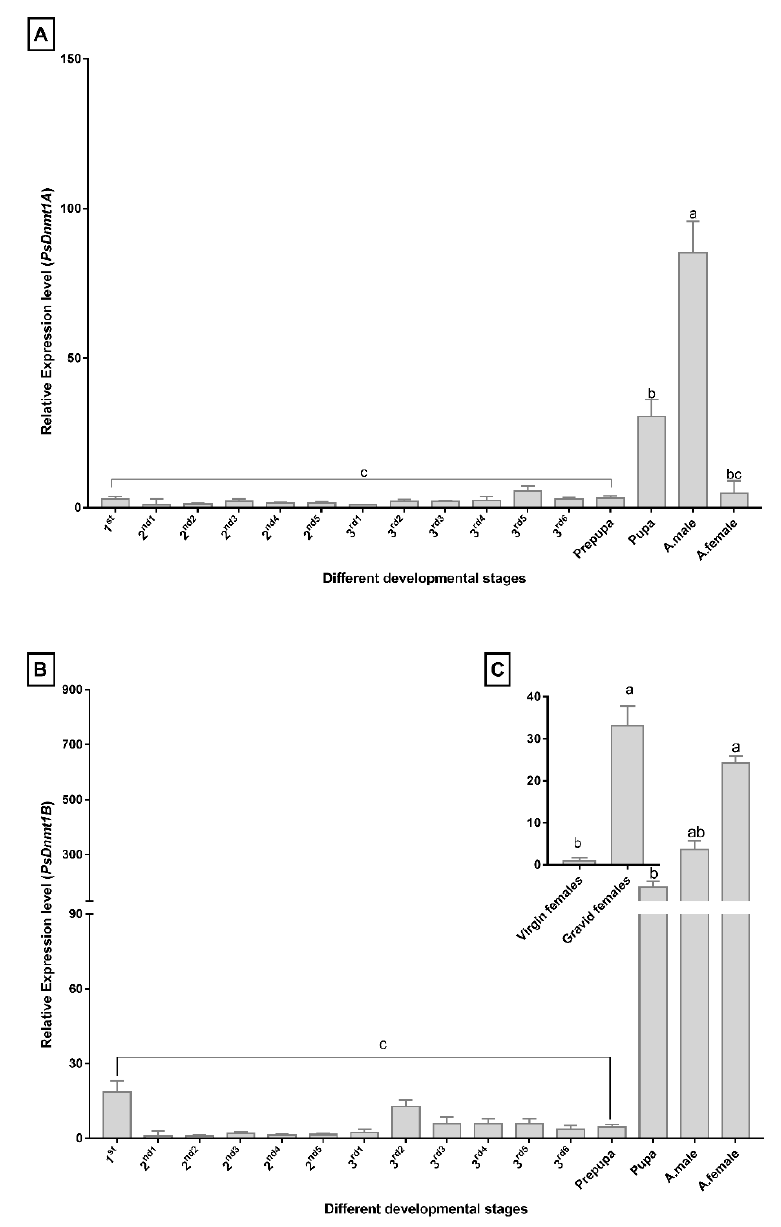
Figure 2. Expression profiles of PsDnmt1A and 1B in all the di ff erent developmental stages of P. solenopsis at di ff erent times. ( A ) Expression levels of PsDnmt1A. ( B ) Expression levels of PsDnmt1B, the first day of the second instar nymphs (2 nd1 ) were arbitrarily assigned a value of 1. ( C ) Expression of PsDnmt1B in virgin females and gravid females; virgin females were arbitrarily assigned a value of 1. Relative expression levels were normalized against the expression of β -actin and visualized as mean ± SE with three biological replicates. Values were analyzed by one-way ANOVA in conjunction with TUKEY test, while Student t-test was used to analyze two groups; and bars with di ff erent lowercase letters (abc) are used to indicate significance at p < 0.05.